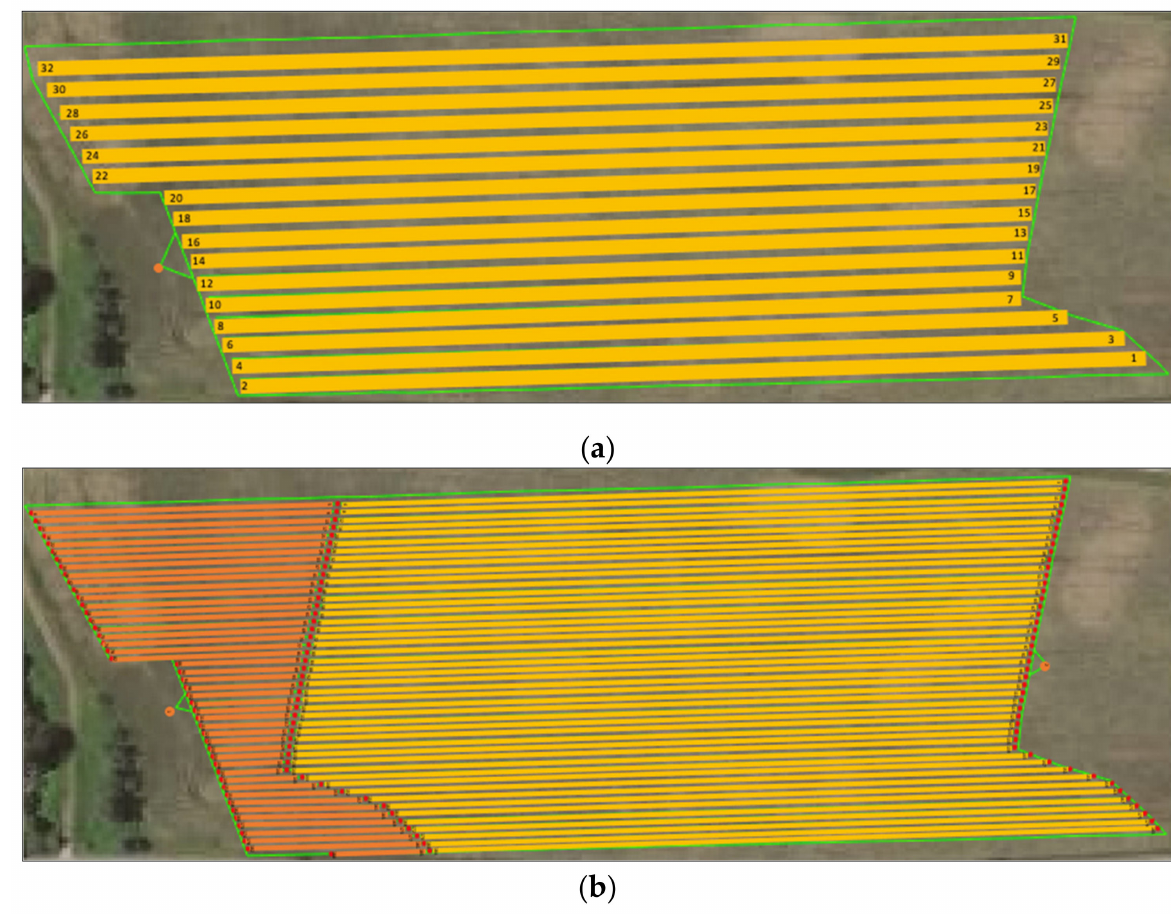
Figure 8. ( a ): The field partitioning for the sample field based on the distributer with the capacity equal to 25 m 3 . ( b ): The field partitioning for the sample field for the robotic application with a small capacity equal to 0.8 m 3